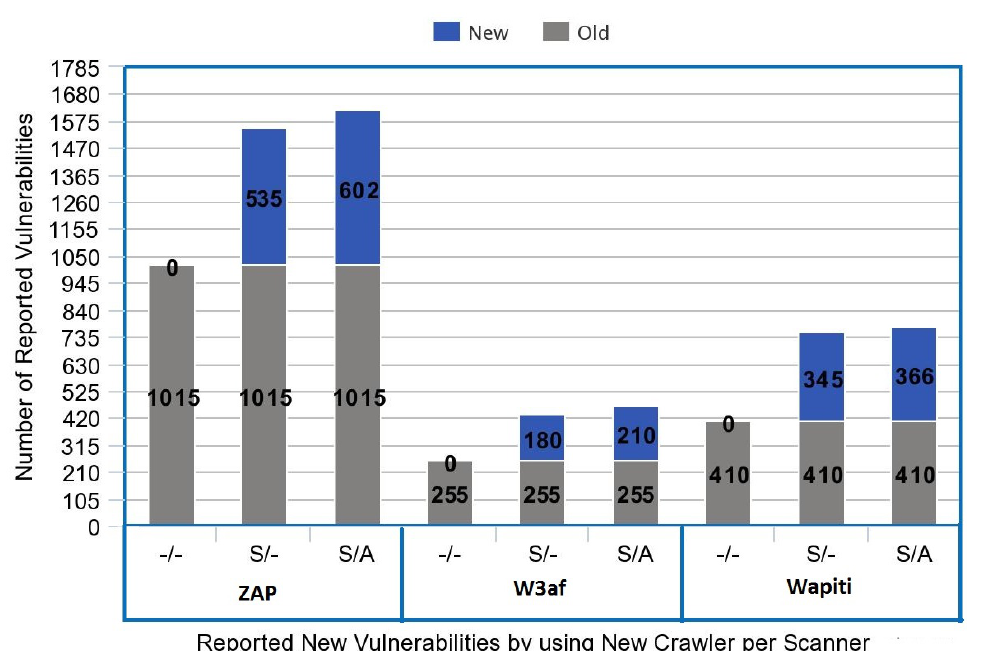
Figure 3. Reported vulnerabilities using before and after Arachni